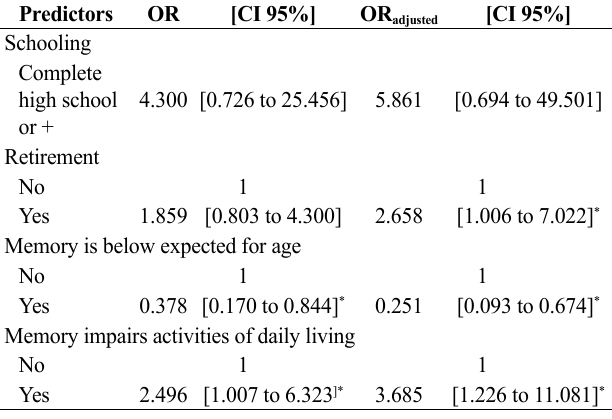
Table 4. Factors associated with the memory lower than expected for age in the